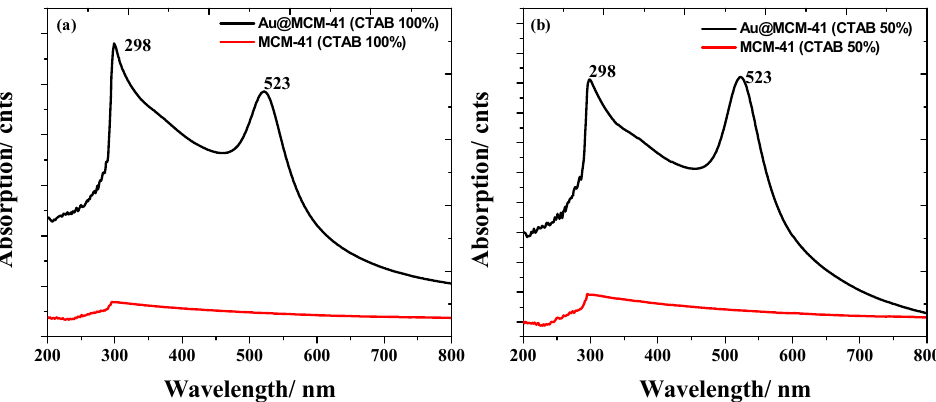
Figure 4. ( a ) UV-Vis absorption of Au–MCM-41–full CTAB and pure MCM-41–full CTAB (100% Figure 4. ( a ) UV ‐ Vis absorption of Au–MCM ‐ 41–full CTAB and pure MCM ‐ 41–full CTAB (100% CTAB); ( b ) the same for Au–MCM-41–50% CTAB and pure MCM-41–50% CTAB); ( b ) the same for Au–MCM ‐ 41–50% CTAB and pure MCM ‐ 41–50% CTAB.